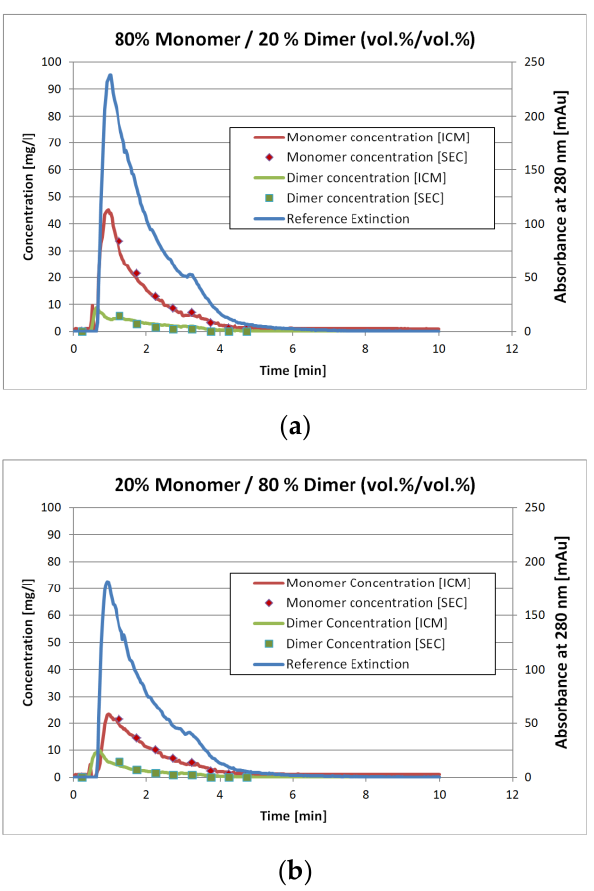
Figure 7. Concentration measurements over time of IgG monomer and dimer after injecting into a continuous stirred-tank reactor: ( a ) Volumetric mixing ratio of 80% monomer and 20% dimer; ( b ) Volumetric mixing ratio of 20% monomer and 80% dimer.